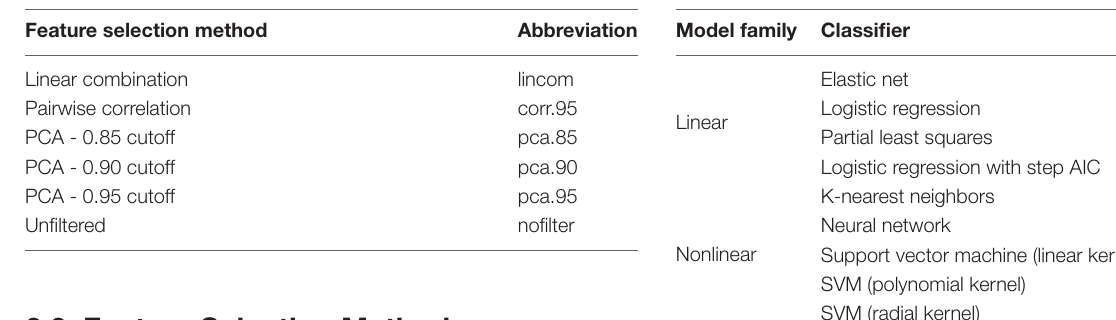
TABLE 2 | Summary of feature selection methods. TABLE 3 | Summary of